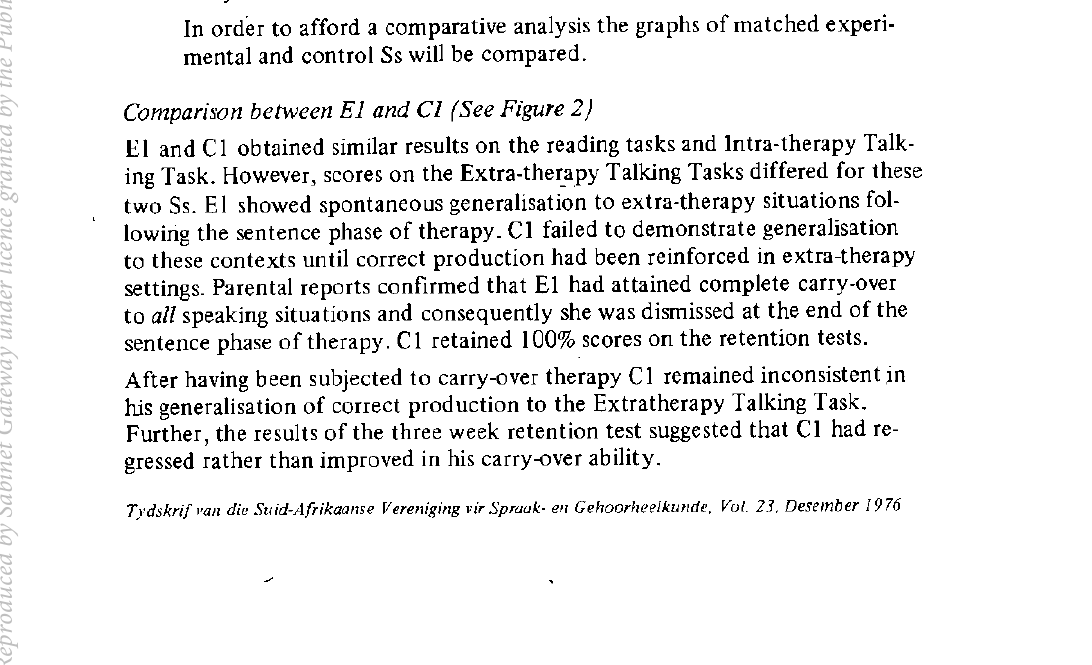
TABLE II. Total Number of correct articulations for all subjects on sound production